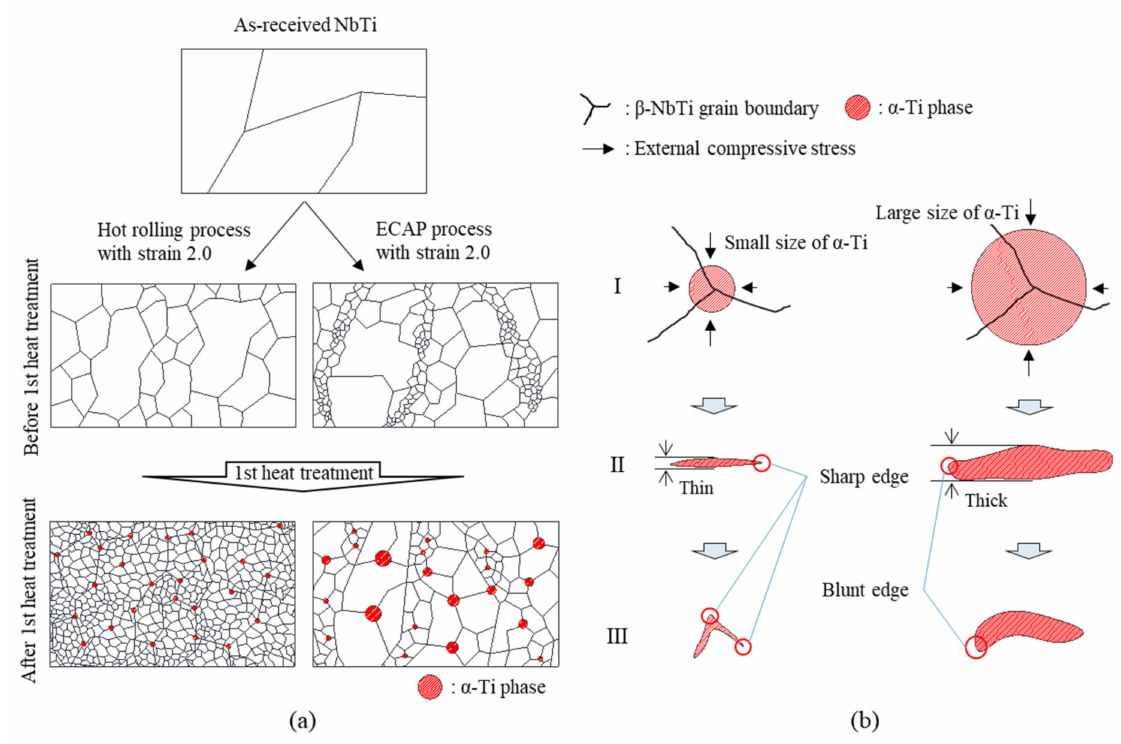
Figure 11. Schematics depicting ( a ) β -NbTi microstructures according to process sequence and ( b ) deformation progress of small and large α -Ti